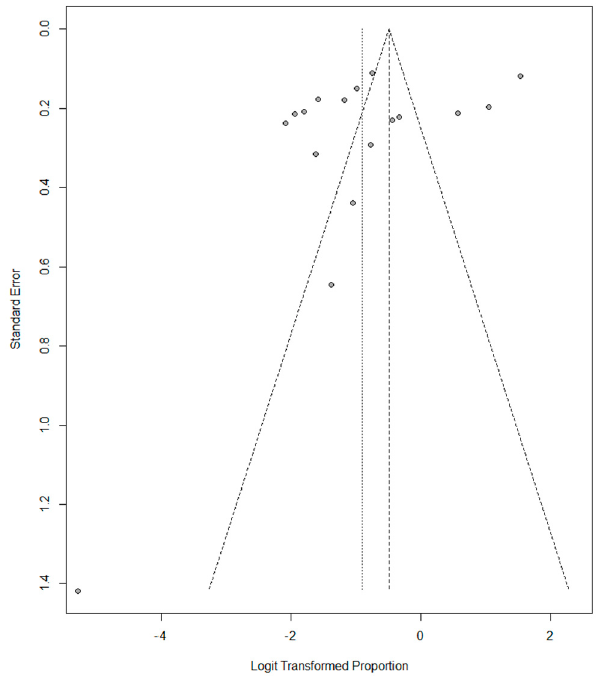
Figure 6. Funnel plot of Vitamin D deficiency in childbearing-aged women.